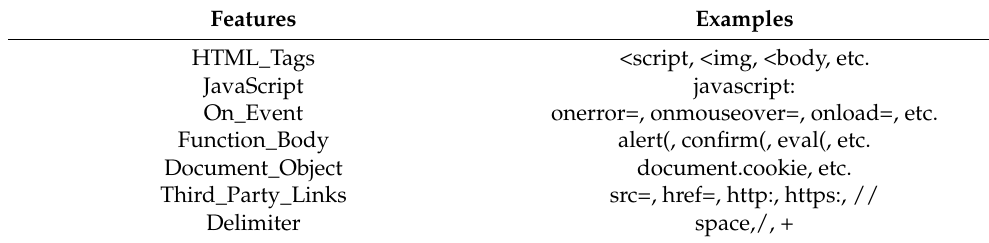
Table 5. Seven new attribute